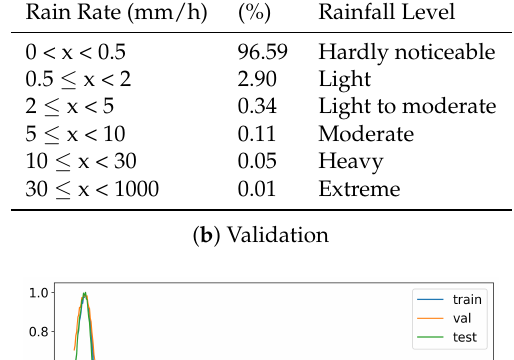
( d ) Distribution plot of the three sets